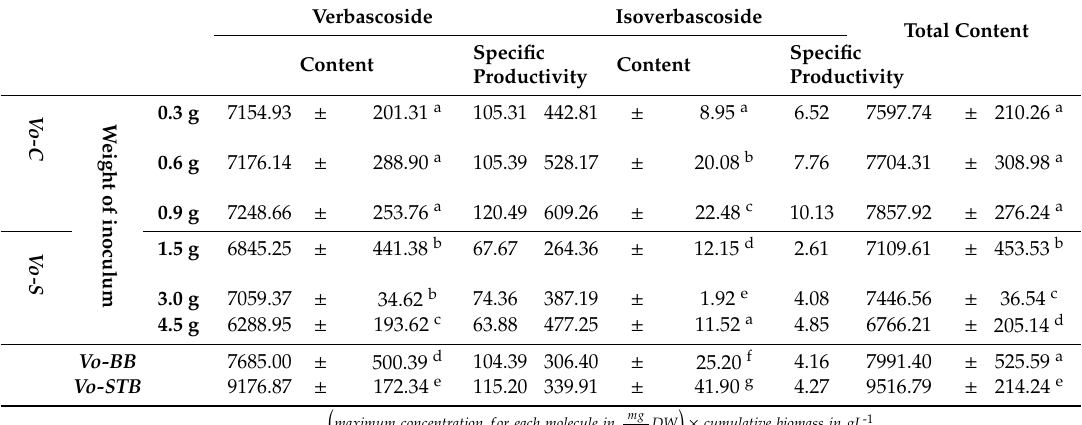
Table 1. Phenylpropanoid glycosides accumulation (mg/100 g DW ± SD) and their specific